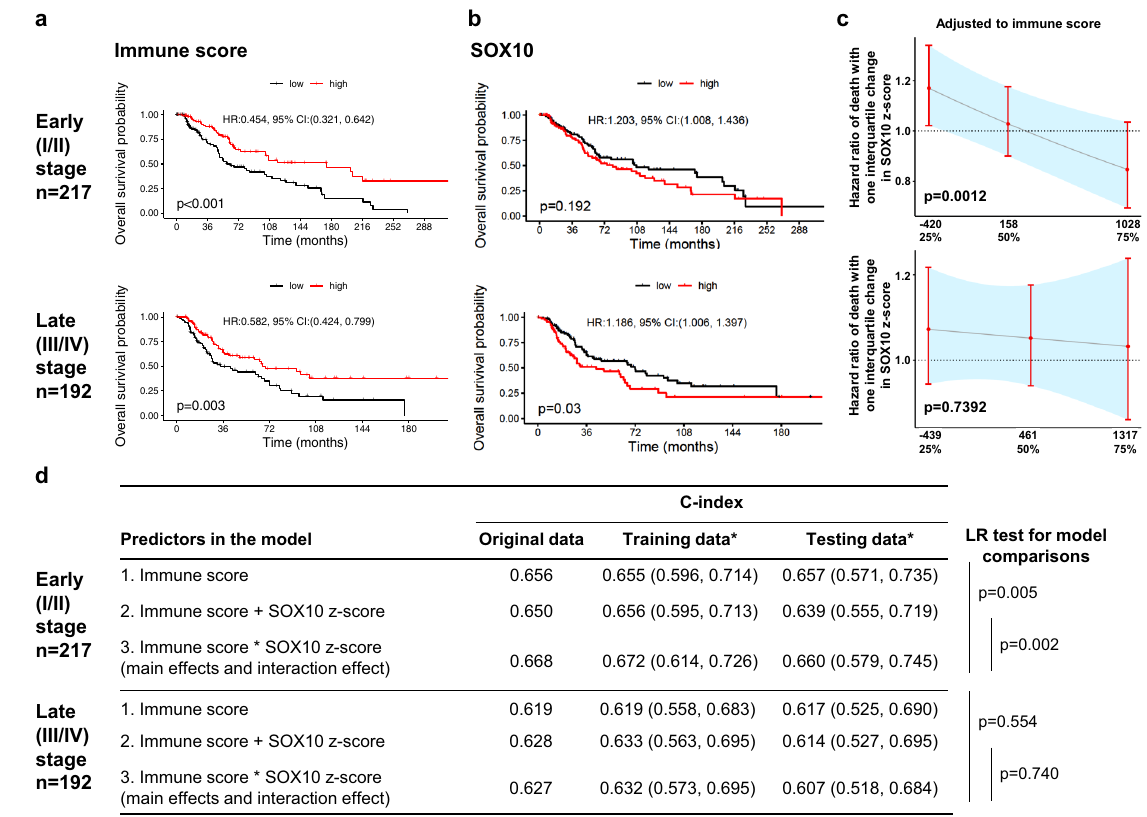
Fig. 3 Prognostic value and interaction of SOX10 and immune score to predict OS in patients with melanoma. a , b Survival (Kaplan – Meier) plots by predictors. The mortality risk (HR of death) was calculated based on per interquartile change in continuous predictors. c HR of death per interquartile change in SOX10 z-score adjusted to immune score. d Likelihood ratio (LR) test showed an improved prognostic performance of immune score via adding SOX10 to predict OS in patients with stage I/II